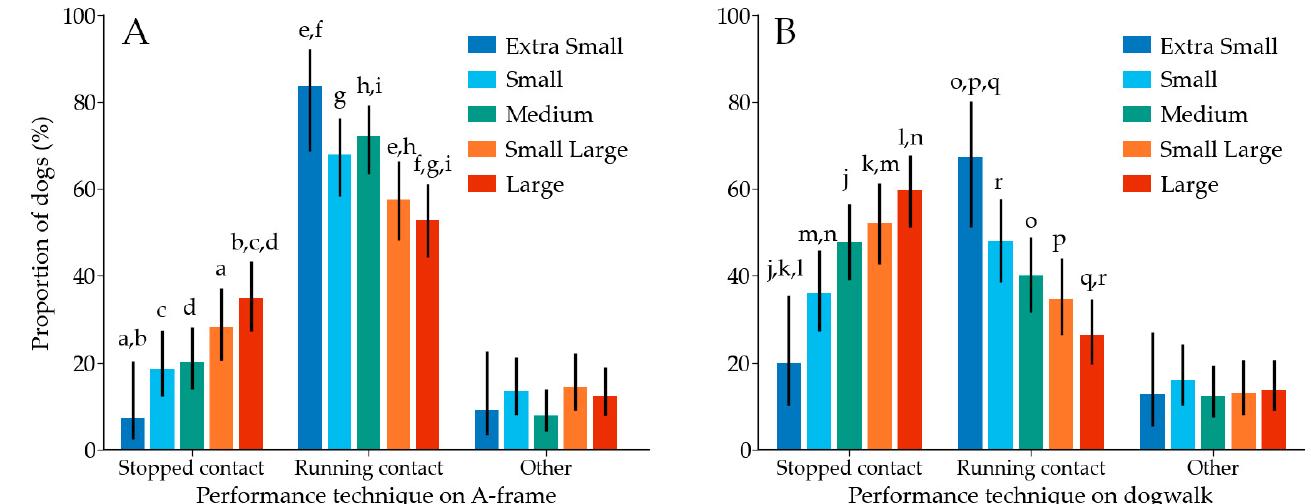
Figure 5. ( A ) Performance technique on A-frame across height categories of dogs. Proportion of dogs within each height category is shown. ( B ) Performance technique on dogwalk across height categories. Same letter indicates a significant difference ( p < 0.05) between two height categories. Error bars are used to indicate 95% confidence intervals.